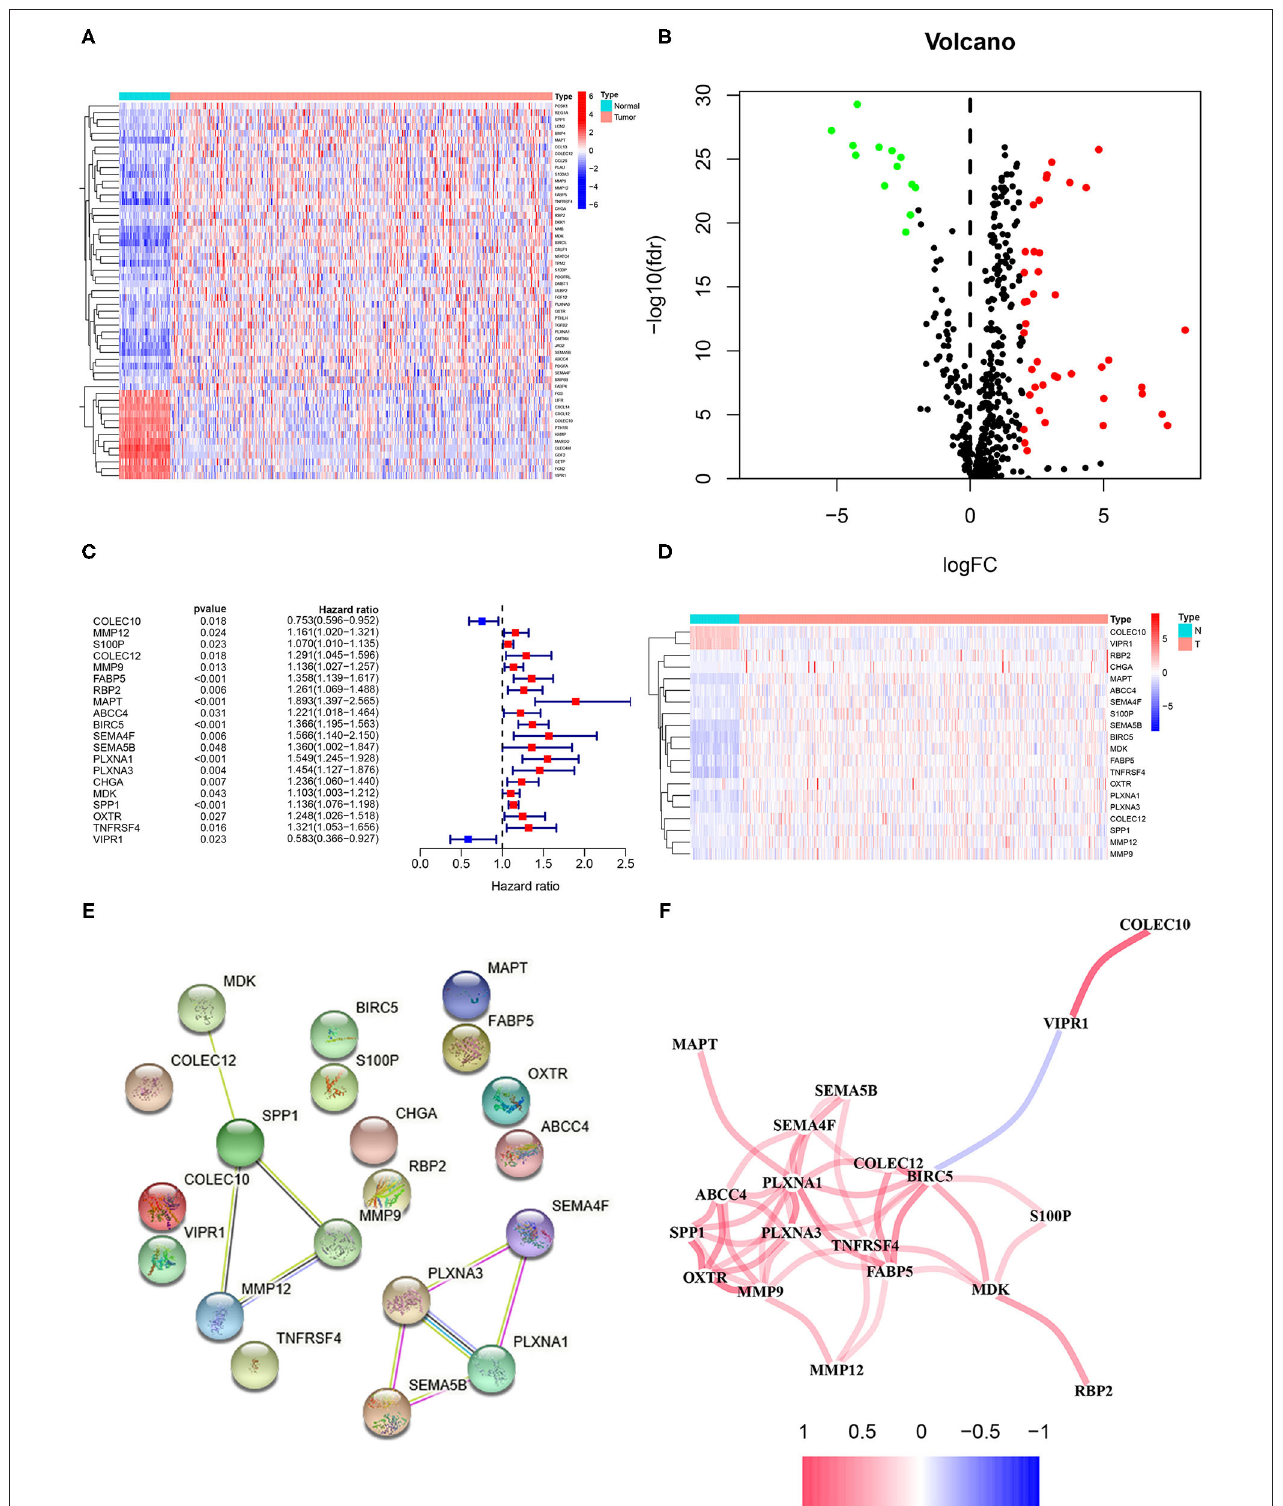
FIGURE 2 | Identification of the epithelial–mesenchymal transition (EMT)-related immune genes with the differential expression and overall survival (OS)-related genes as well as plotting of the protein–protein interaction (PPI) and gene–gene interaction (GGI). (A) The heatmap and (B) volcano plots of the differentially expressed (DE)-EMT-related immune genes in hepatocellular carcinoma (HCC). (C) The forest and (D) heatmap plots of the OS-related genes based on the univariate Cox regression analysis. Network plot of (E) the PPI and (F) GGI.